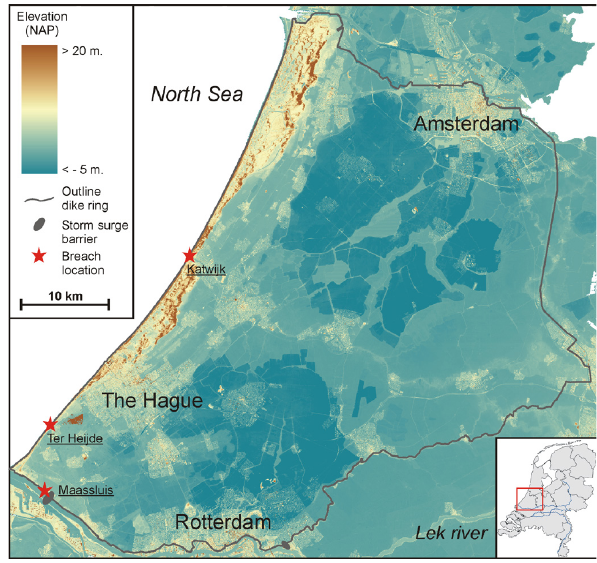
Fig. 1. Elevation map (source: AHN) of the case-study area with some geographic locations and the breach locations considered in this